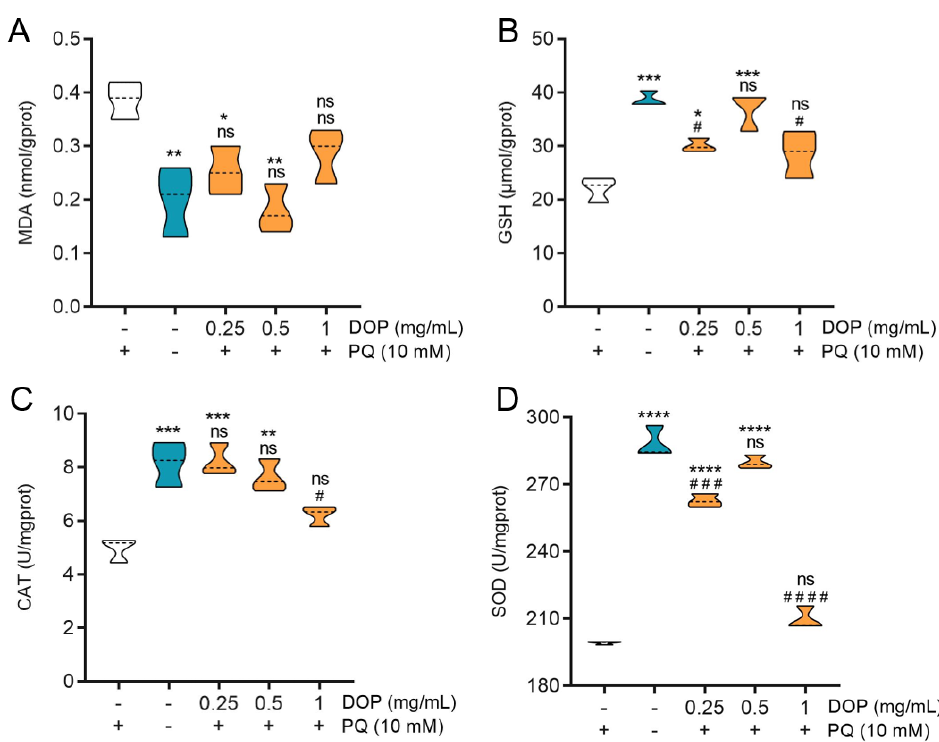
Figure 5. ( A ) MDA levels, antioxidant enzyme activities, ( B ) GSH levels, ( C ) CAT, and ( D ) SOD in the worms under PQ stress. Data are presented as mean ± SD (* p < 0.05, ** p < 0.01, *** p < 0.001, **** p < 0.0001, as compared with negative control worms, # p < 0.05, ### p < 0.001, #### p < 0.0001, as